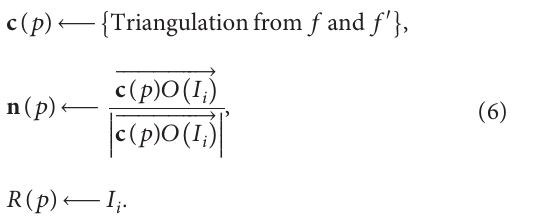
Figure 10: Schematic diagram of the three-dimensional recon- struction of